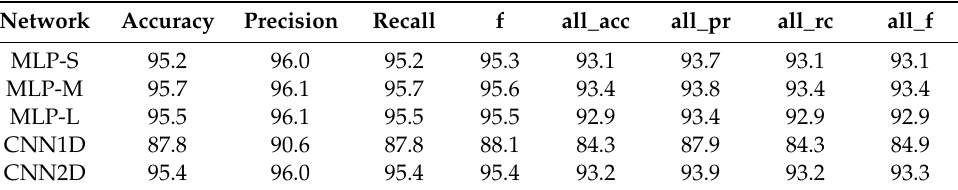
Table 6. Results of K-fold cross-validation without HQ.